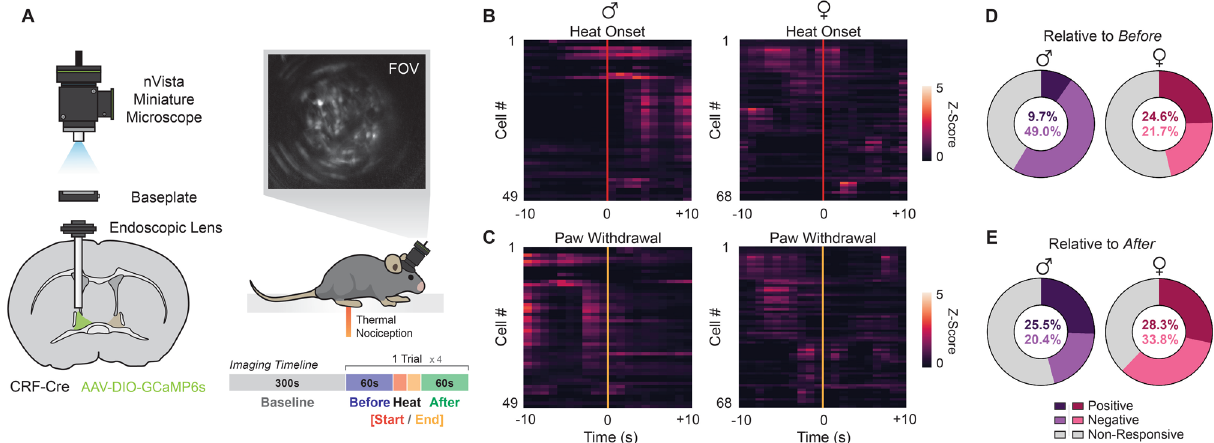
Figure 1. Measurement of Single-Cell Ca 2+ Activity in BNST CRF Neurons During Pain ( A ) Miniature microscope imaging in BNST CRF neurons. (Left) Diagram of GCaMP6s infusion and endoscopic lens / baseplate implantation in the BNST of CRF-Cre mice. (Upper-Right) Imaging field-of-view (FOV) depicting GCaMP6s expression in BNST CRF neurons. (Lower-Right) Experimental timeline with schematic of BNST CRF imaging during behavioral assessment of thermal nociceptive sensitivity. Epochs relative to noxious heat exposure are color-coded: Before (blue), Heat Start (red), Heat End (orange), and After (green). To ensure that epochs represent equal amounts of time on a trial-by-trial basis, epoch lengths were quantitatively defined as half the duration of heat exposure for each specific subject and trial. ( B–C ) Peri-event heatmap of average BNST CRF activity surrounding ( B ) heat onset (red line) and ( C ) paw withdrawal (orange line) for male (left column; n = 49 cells / 7–30 cells per mouse) and female (right column; n = 68 cells / 8–19 cells per mouse) subjects. Lighter shades of color correspond to higher z-scores, a metric indicative of greater changes in Ca 2+ activity relative to baseline. ( D–E ) Total percentage of pain responsive BNST CRF neurons for male (purple) and female (magenta) subjects across trials. Cells that respond to heat exposure with positive (darker), negative (lighter), and no (grey) changes in z-score were determined relative to the Before and After epochs, as demarcated by the onset of ( D ) heat exposure [“Relative to Before ”] and ( E ) paw withdrawal [“Relative to After ”] respectively (Wilcoxon rank- sum, P < 0.05). Data are shown as mean ± SEM. * P < 0.05; ** P < 0.01; *** P < 0.001, **** P <